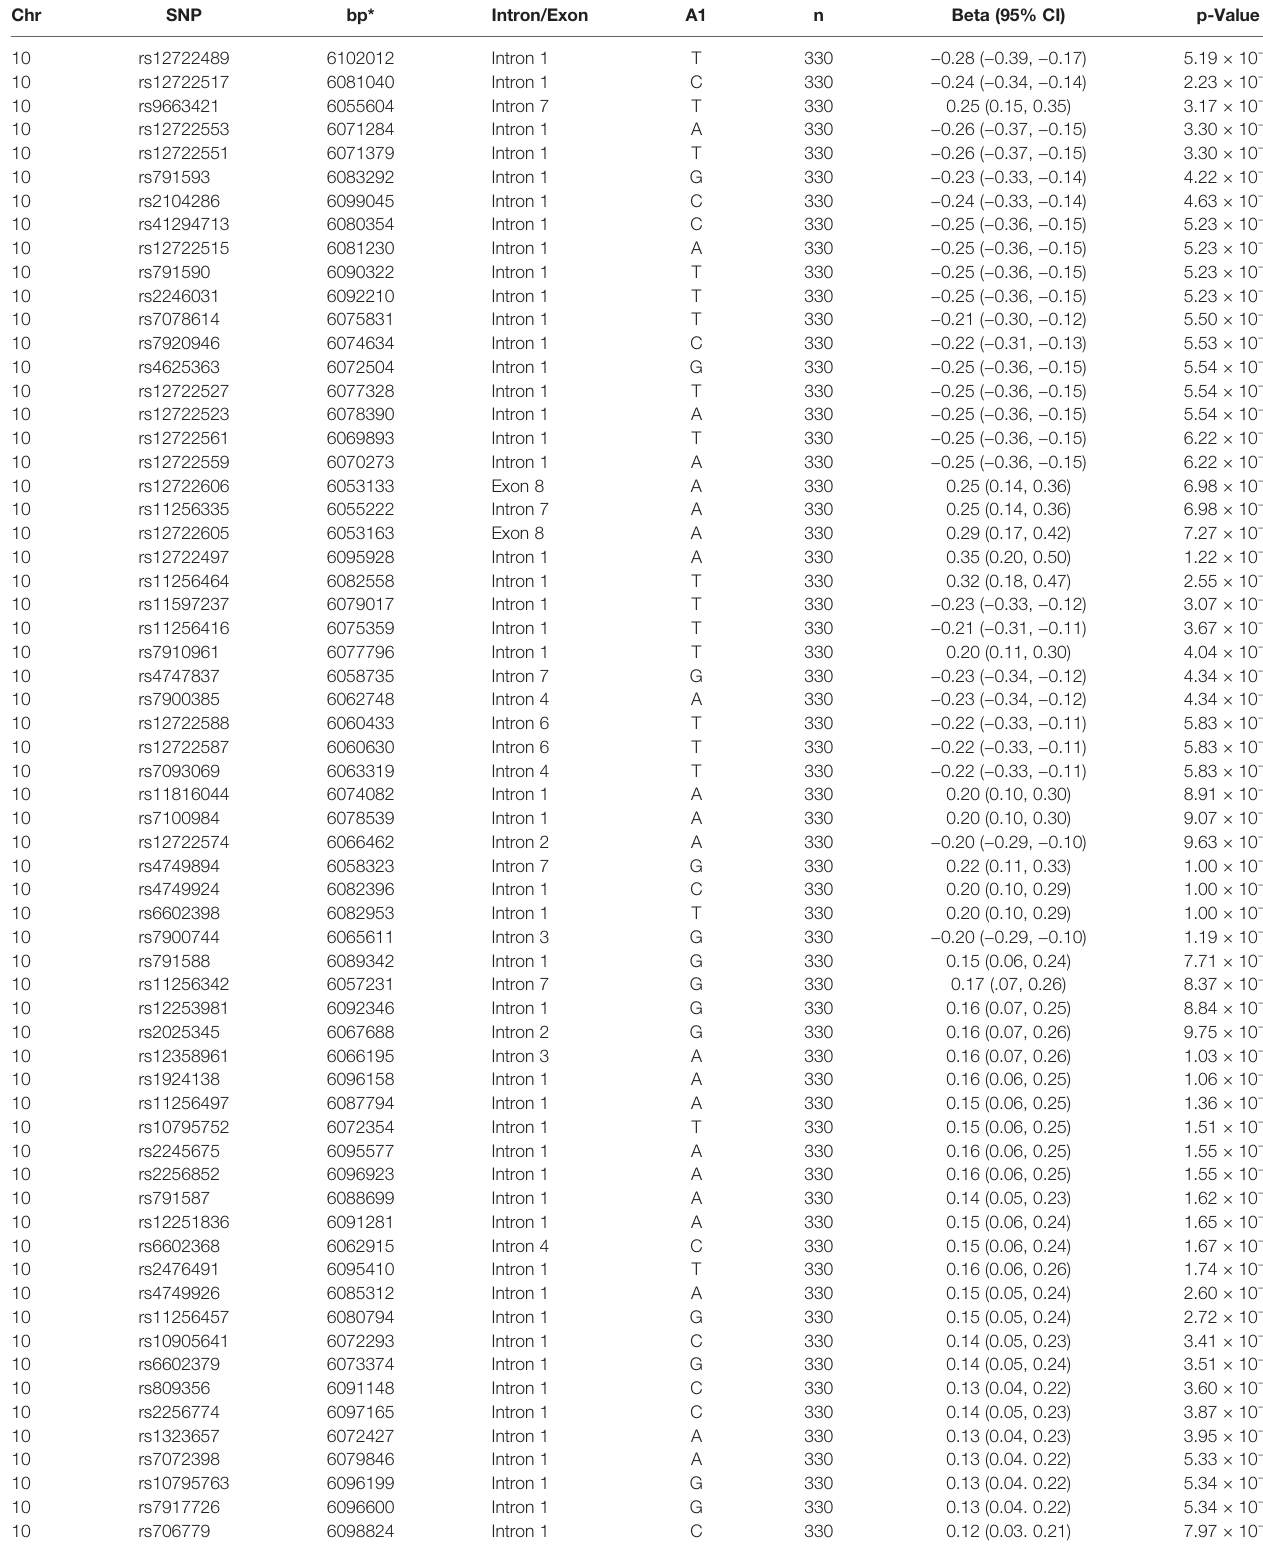
TABLE 3 | Imputed IL2RA genotypes and their signi fi cant associations with sIL-2R in plasma.